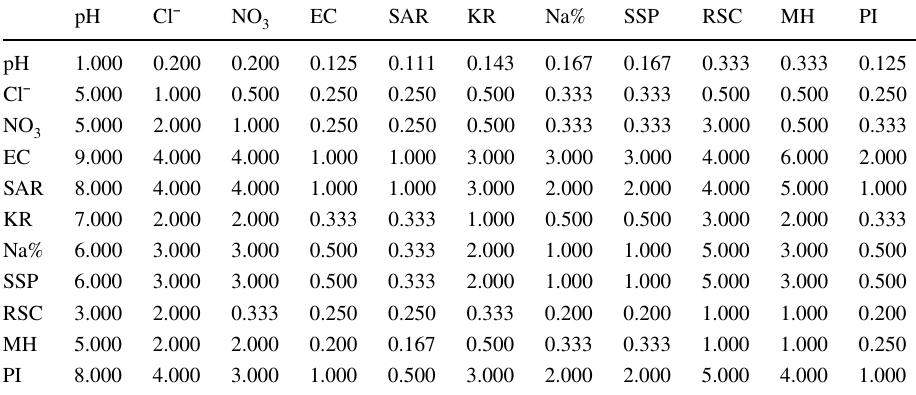
Table 3 Pair-wise comparison matrix